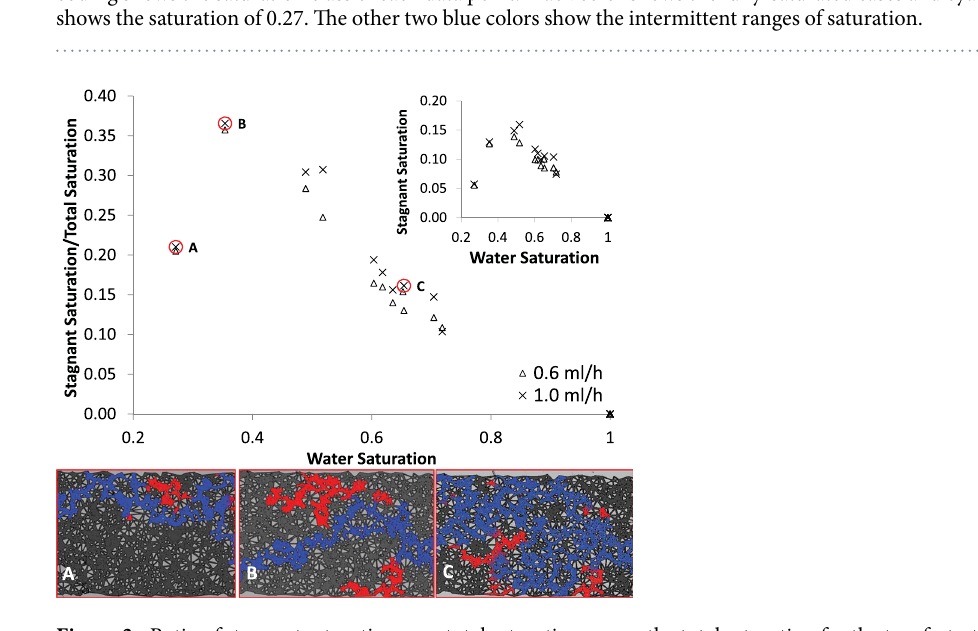
Figure 3. Ratio of stagnant saturation over total saturation versus the total saturation for the two fastest ink injection rates of 0.6 ml/h ( Δ ) and 1.0 ml/h ( × ). Inset: stagnant saturation versus the total saturation. Stagnant (red) and flowing (blue) water-filled networks of the micro-model at three different saturations ( A , B , C ) have been shown in the color